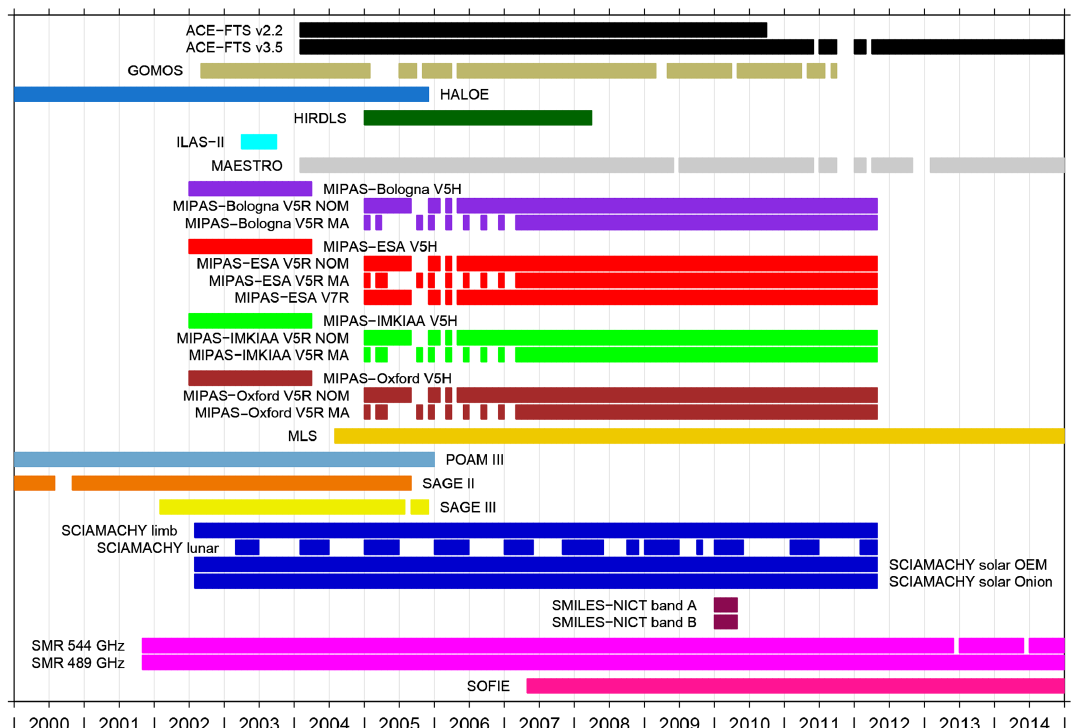
Figure 1. The data sets that were included in the comparisons and their corresponding time coverage on a monthly basis. Only data obtained since 2000 are